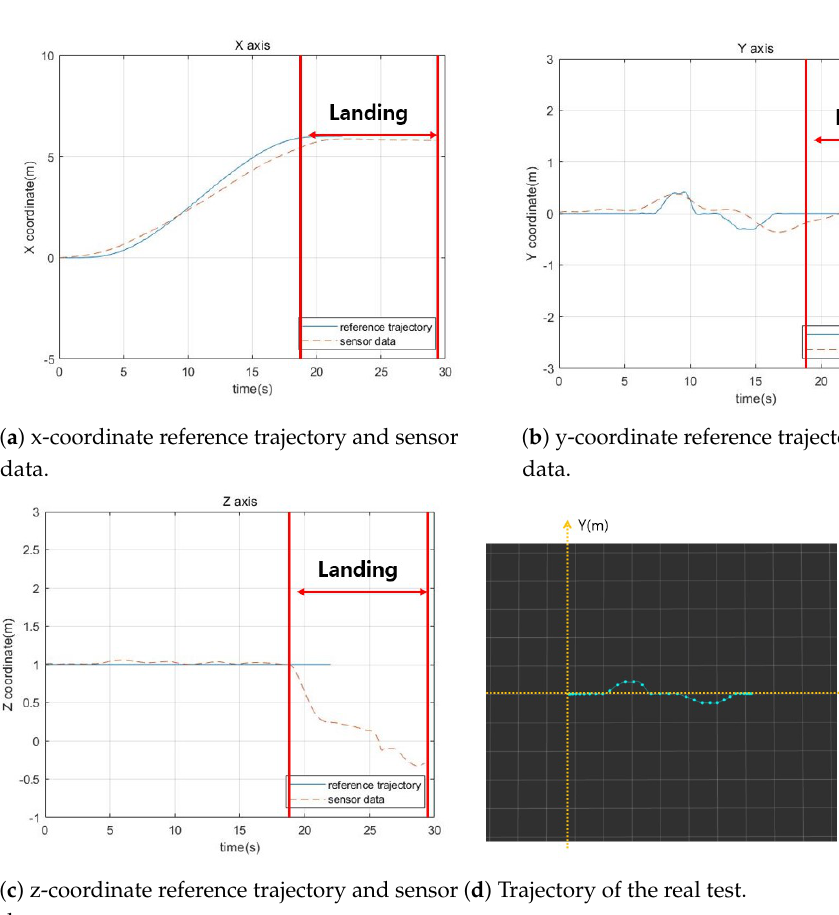
Figure 12. Reference trajectory and sensor data graph of the real